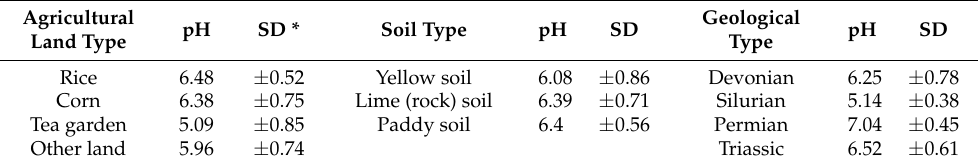
Table 1. pH values of different agricultural land types, soil types and geological types.